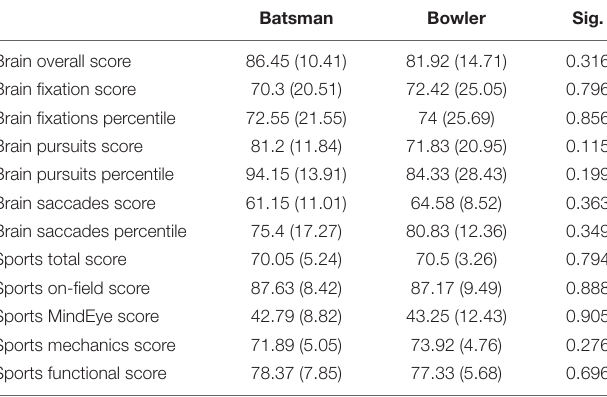
TABLE 4 | Mean comparison of oculomotor variables by position. Batsman